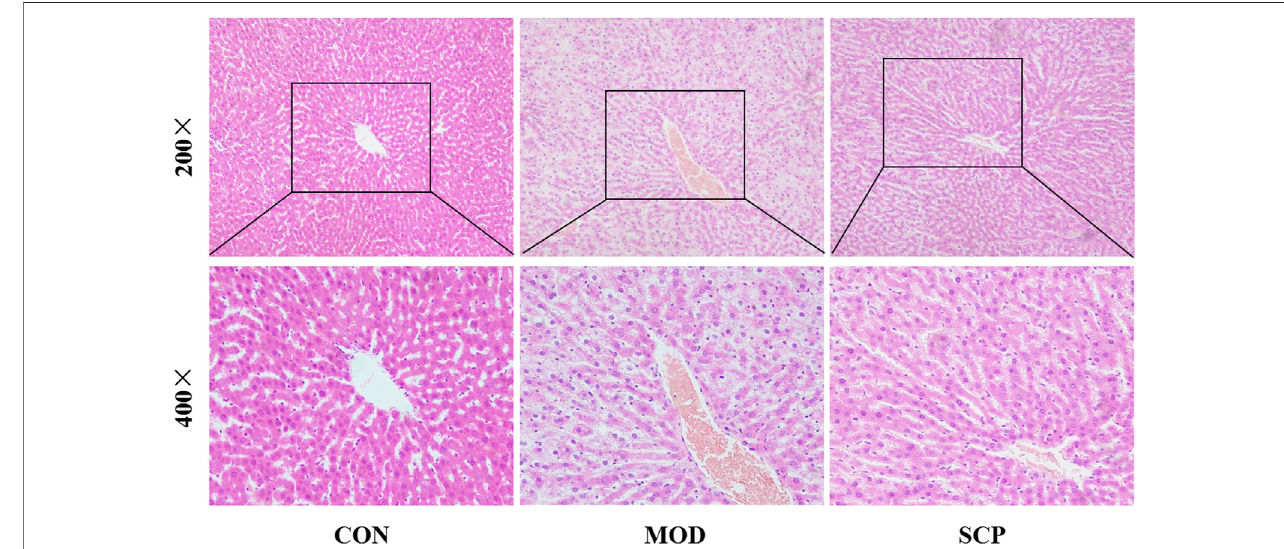
FIGURE 3 | Effects of SCP on histomorphological changes in the live tissue of